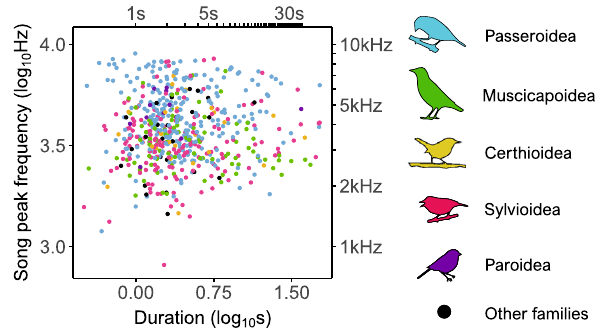
Figure 3. Relation of song peak frequency and song duration across species. Scatterplot of song peak frequency on song duration across species. Species are colored by